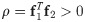
Stimulus encoding fidelity and uniqueness with constant additive noise.The original stimuli are represented as points in a three dimensional space (bigger red and blue dots, one stimulus from each of two levels of the latent variable). The original stimuli are then projected into a standard (i.e. orthogonal) basis {e1,e2} that spans the same subspace as two (possibly non-orthogonal) filters {f1,f2}. This subspace lies in the e1,e2 plane. The ellipse represents uncertainty about each encoded stimulus. The size and orientation of each uncertainty ellipse is determined by the stimulus (red dot), each filter’s response noise, and correlation between the filters. Red Gaussian bumps represent the noisy response distributions of F1 and F2 to the red stimulus. A Positively correlated (ρ=f1Tf2>0) filters. B Orthogonal (i.e. uncorrelated; ρ=f1Tf2=0) filters. C Negatively correlated (ρ=f1Tf2<0) filters. D-F Rotated versions of A-C. Orthogonal filters (B,E) provide rotation invariant encoding; non-orthogonal (i.e. positively and negatively correlated) filters do not (A,C,D,F).